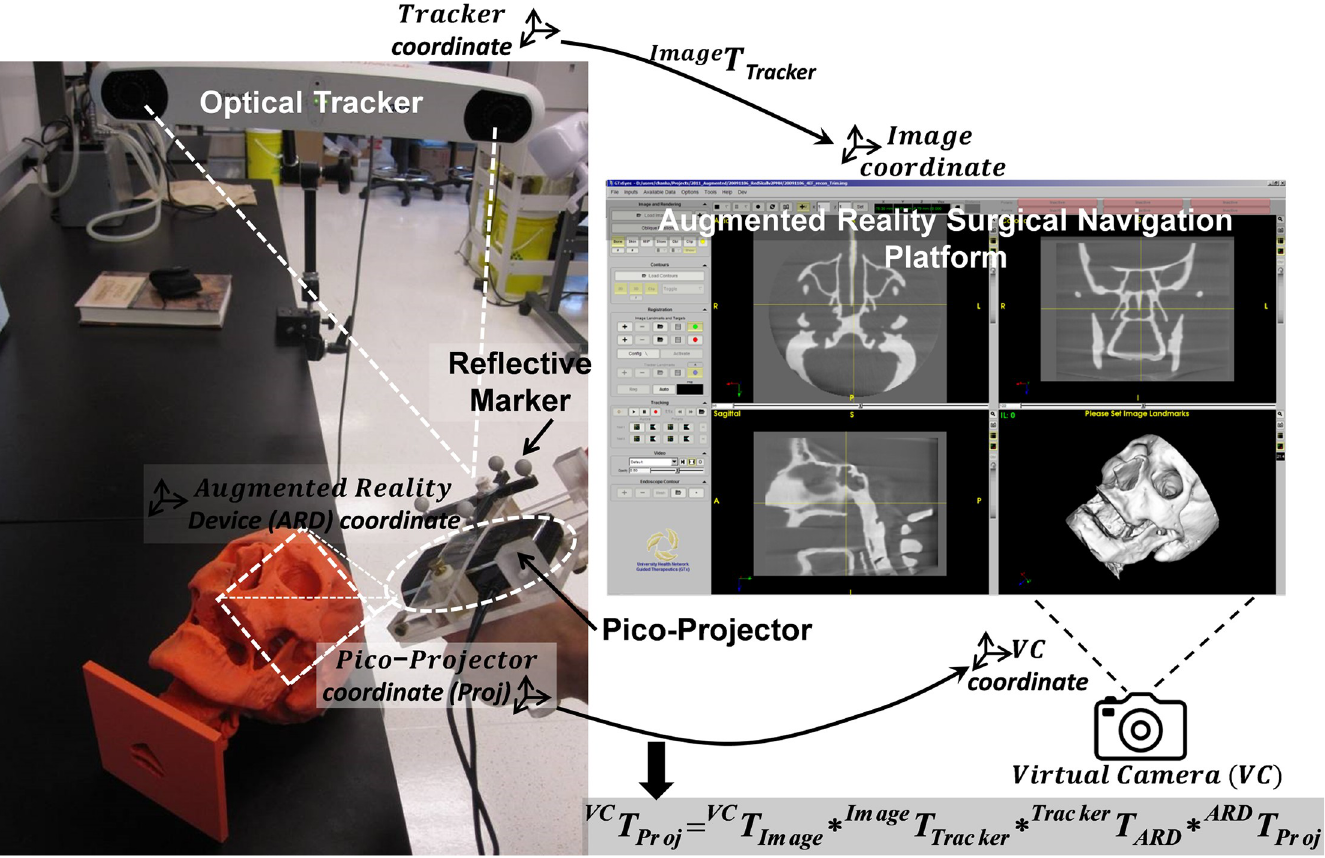
Fig 1. Prototype augment reality surgical navigation platform consists of optical tracking system and tracked pico-projector.